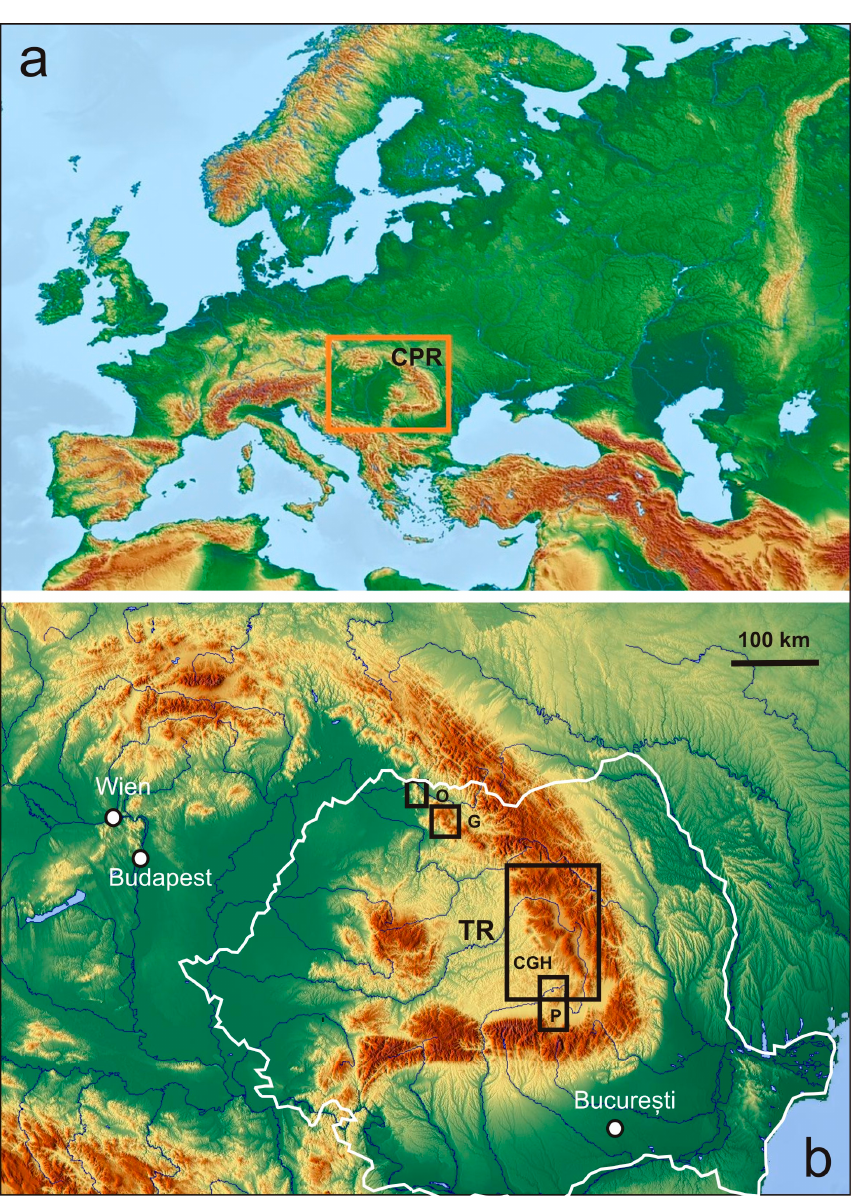
Figure 1. Location of the Carpathian–Pannonian Region (CPR) in Europe ( a ) and location of the study areas within the Carpathian–Pannonian Region ( b ): O—Oa ş Mts; G—Gutâi Mountains; CGH—C ă limani-Gurghiu-Harghita range; P—Per ş ani Mountains; TR—Transylvanian Basin. Map source https://ontheworldmap.com/europe/physical-map-of-europe.jpg, accessed on 2 April 2022.